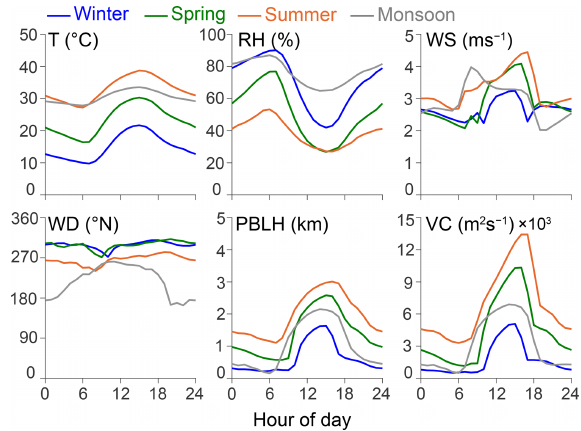
Figure 1. Diurnal profiles of meteorological parameters (tempera- ture, relative humidity, wind speed, wind direction, PBLH, and VC) by season. Average values by season and hour of day are presented for all parameters except wind direction. The median value is pre- sented for wind direction. Ventilation coefficient (VC) = PBLH × wind